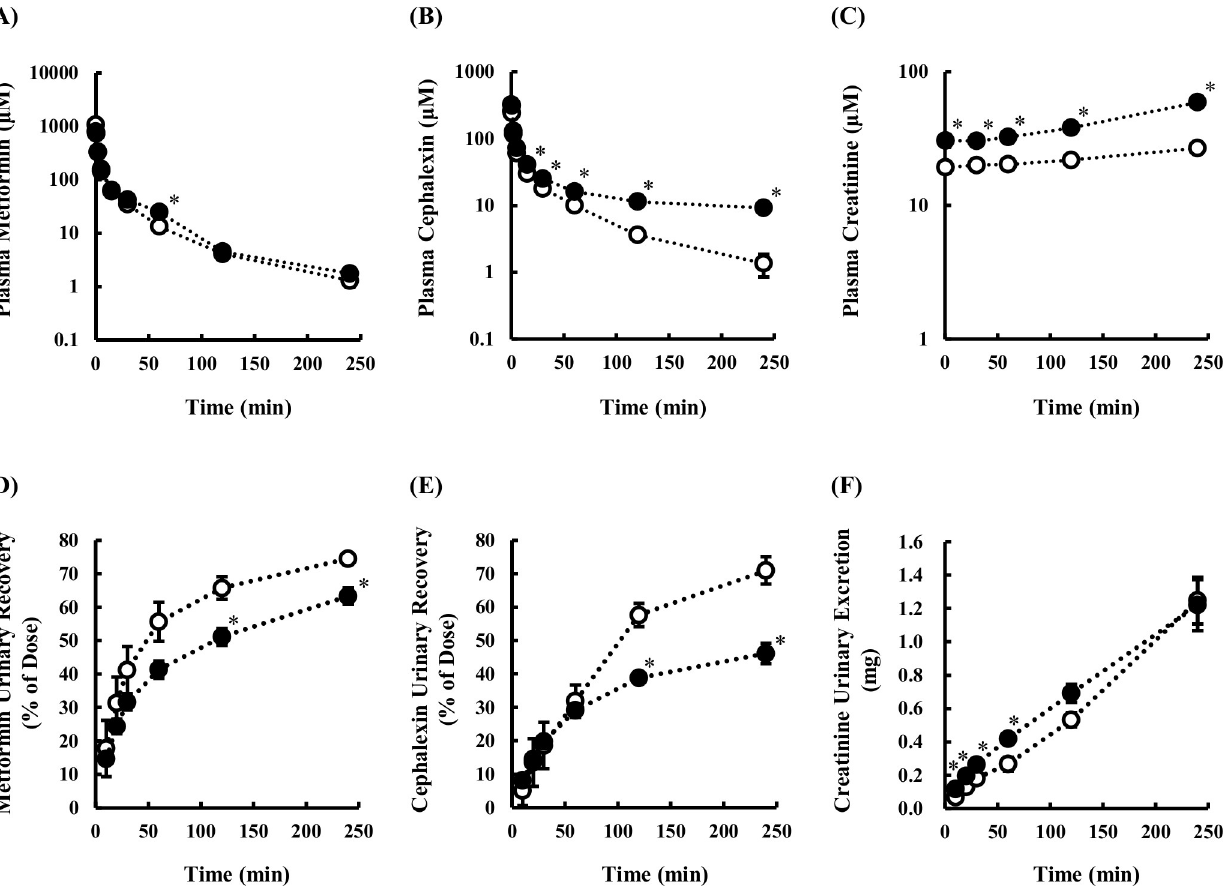
Fig 3. Plasma concentration-time profiles of metformin (A), cephalexin (B) and creatinine (C) and cumulative urinary excretions of metformin (D), cephalexin (E) and creatinine (F) in control (open circles) and hyperuricemic rats (closed circles). Concentrations of metformin, cephalexin and creatinine in plasma and urine were measured up to 4 h after intravenous administration of metformin (30 mg/kg) or cephalexin (10 mg/kg). Creatinine concentration represents endogenous creatinine. Data are presented as mean ± SEM (n = 3). � p < 0.05 vs. control rats.